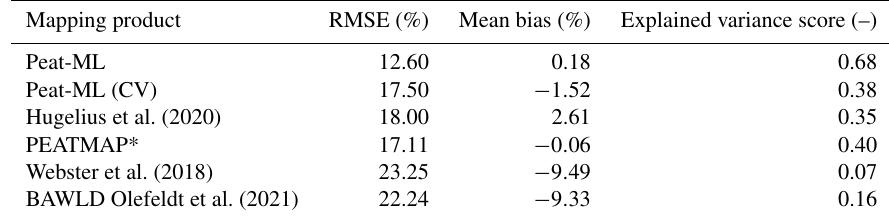
Table 4. Statistical comparison of peatland map products as evaluated against the DUC dataset (Smith et al., 2007). RMSE is the root-mean- square error. The explained variance score (calculated as 1 − σ deviation) has a best possible value of 1.0, with lower scores indicating worse performance.